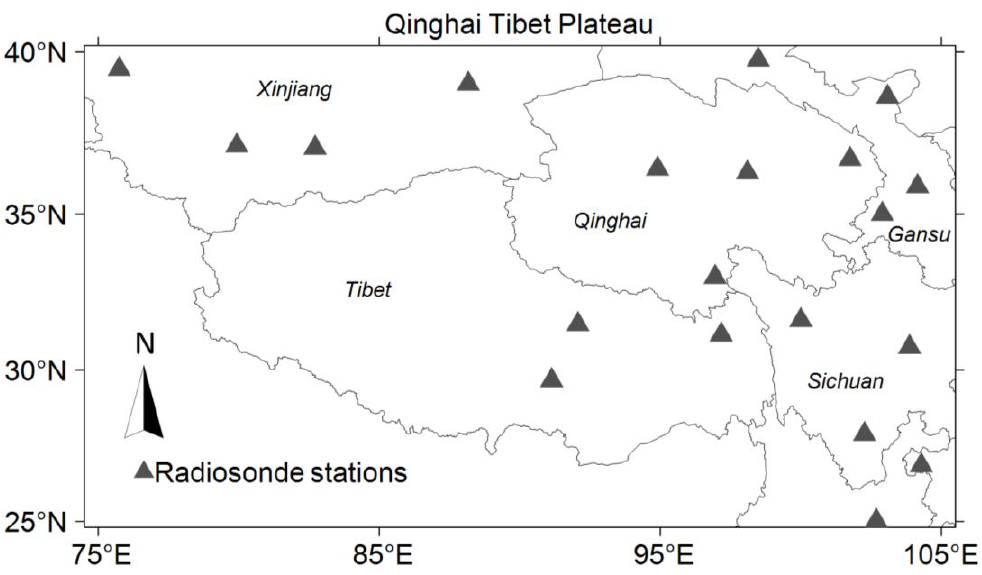
Figure 1. Distribution of the 20 radiosonde stations.